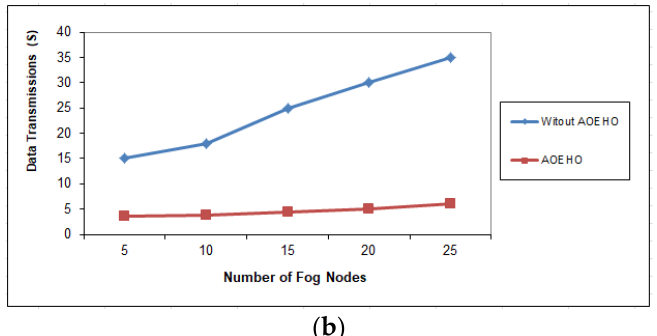
Figure 8. Data transmission between fog nodes = 25 nodes. ( a ) Size of data replication = 64 MB. ( b ) Size of data replication = 320 MB.